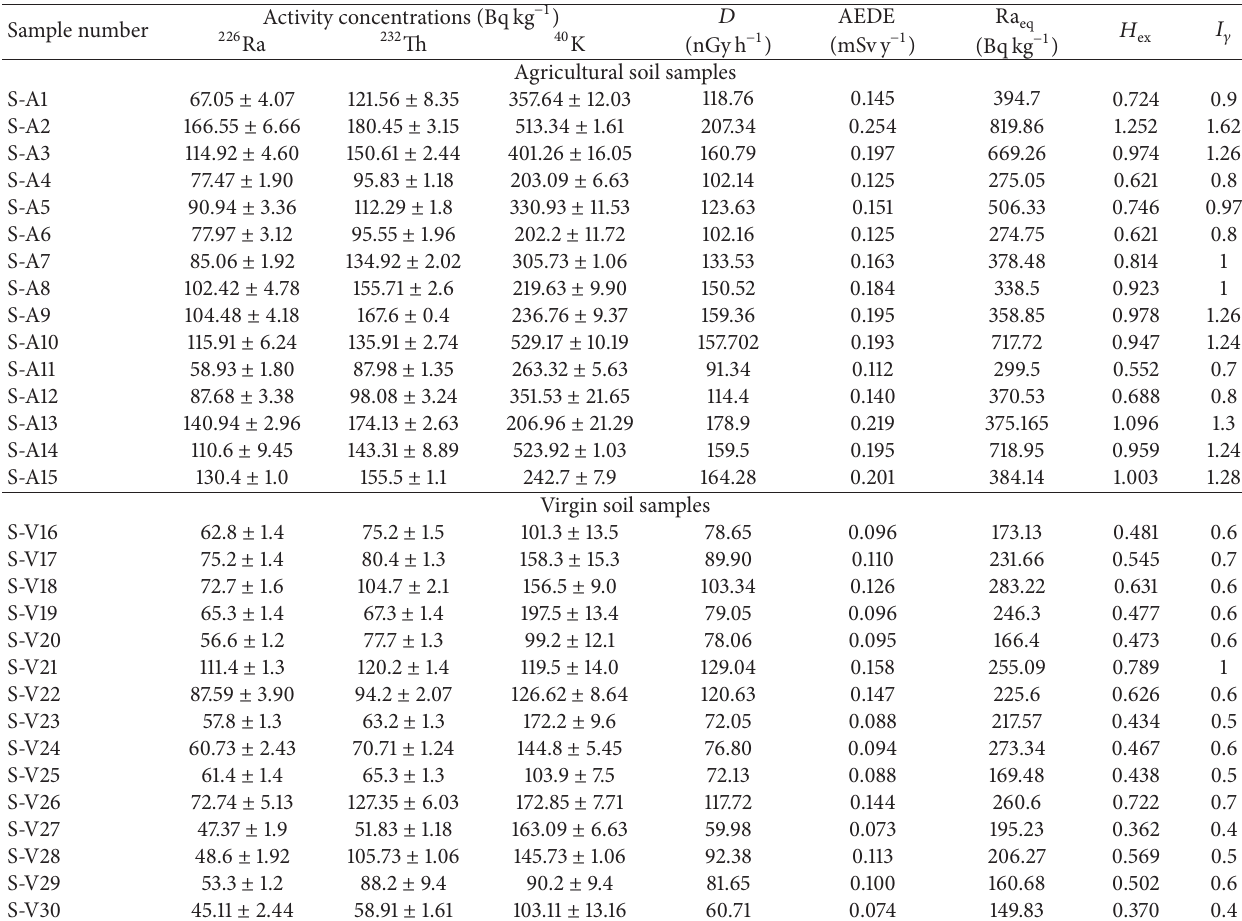
Table 2: The activity concentrations of 226 Ra, 232 Th, and 40 K (Bqkg −1 ) in agricultural and virgin soil samples collected from Kedah soil of north